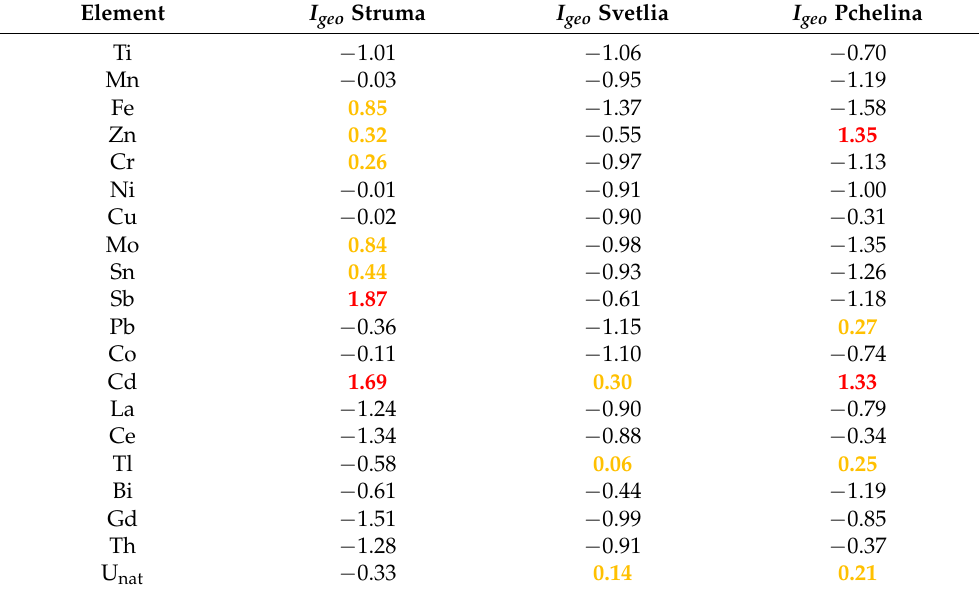
Table 3. Geoaccumulation index ( I geo ) in the three sampling points (yellow—uncontaminated to moderately contaminated sample, red—moderately contaminated sample).